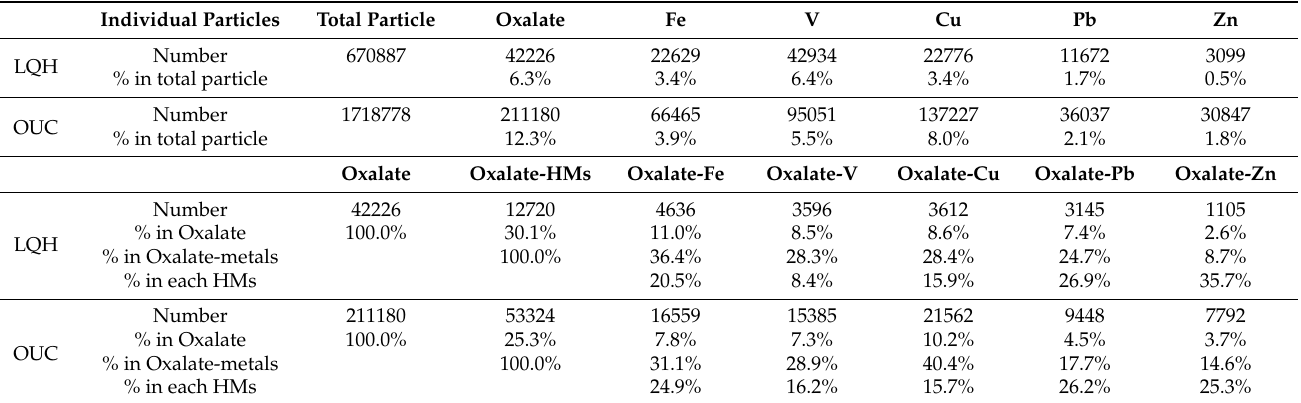
Table 1. Particle number statistics captured by